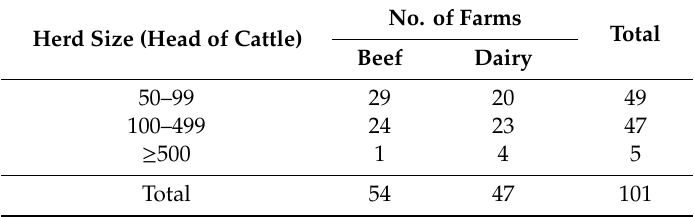
Table A1. Sampled farms distribution per livestock category and herd size.